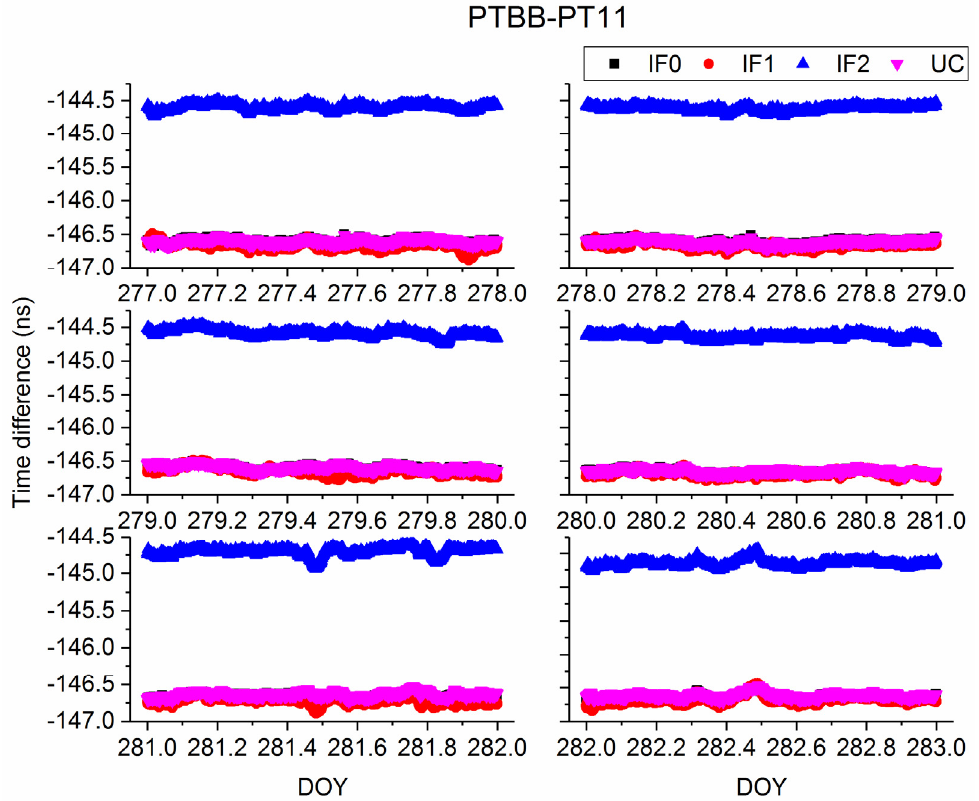
Figure 8. Comparison of time difference of PTBB-PT11 obtained from different models.